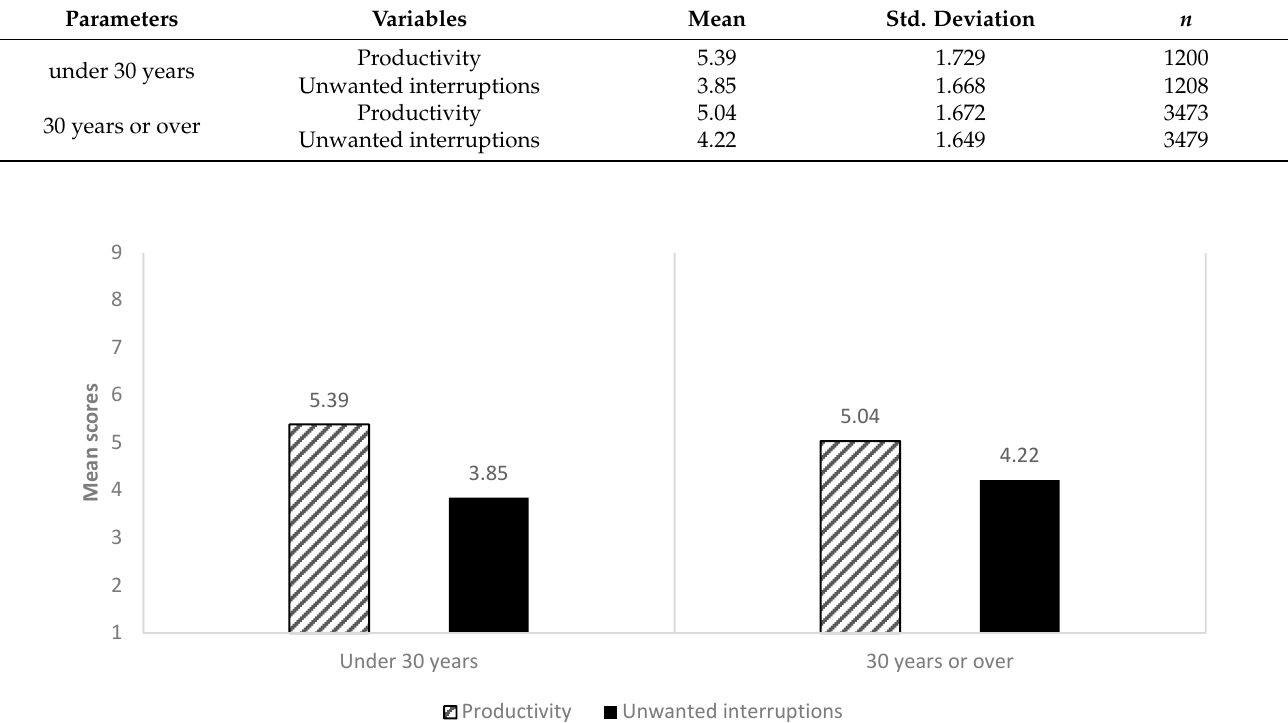
Figure 4. Comparative analysis of mean scores of perceived productivity and unwanted interruptions between under 30 years and 30 years or over. Table 11. One-way ANOVA analysis comparing perceived productivity and unwanted interruptions for under 30 years and Table 10. Descriptive statistics of productivity and unwanted interruptions for under 30 years and 30 years or